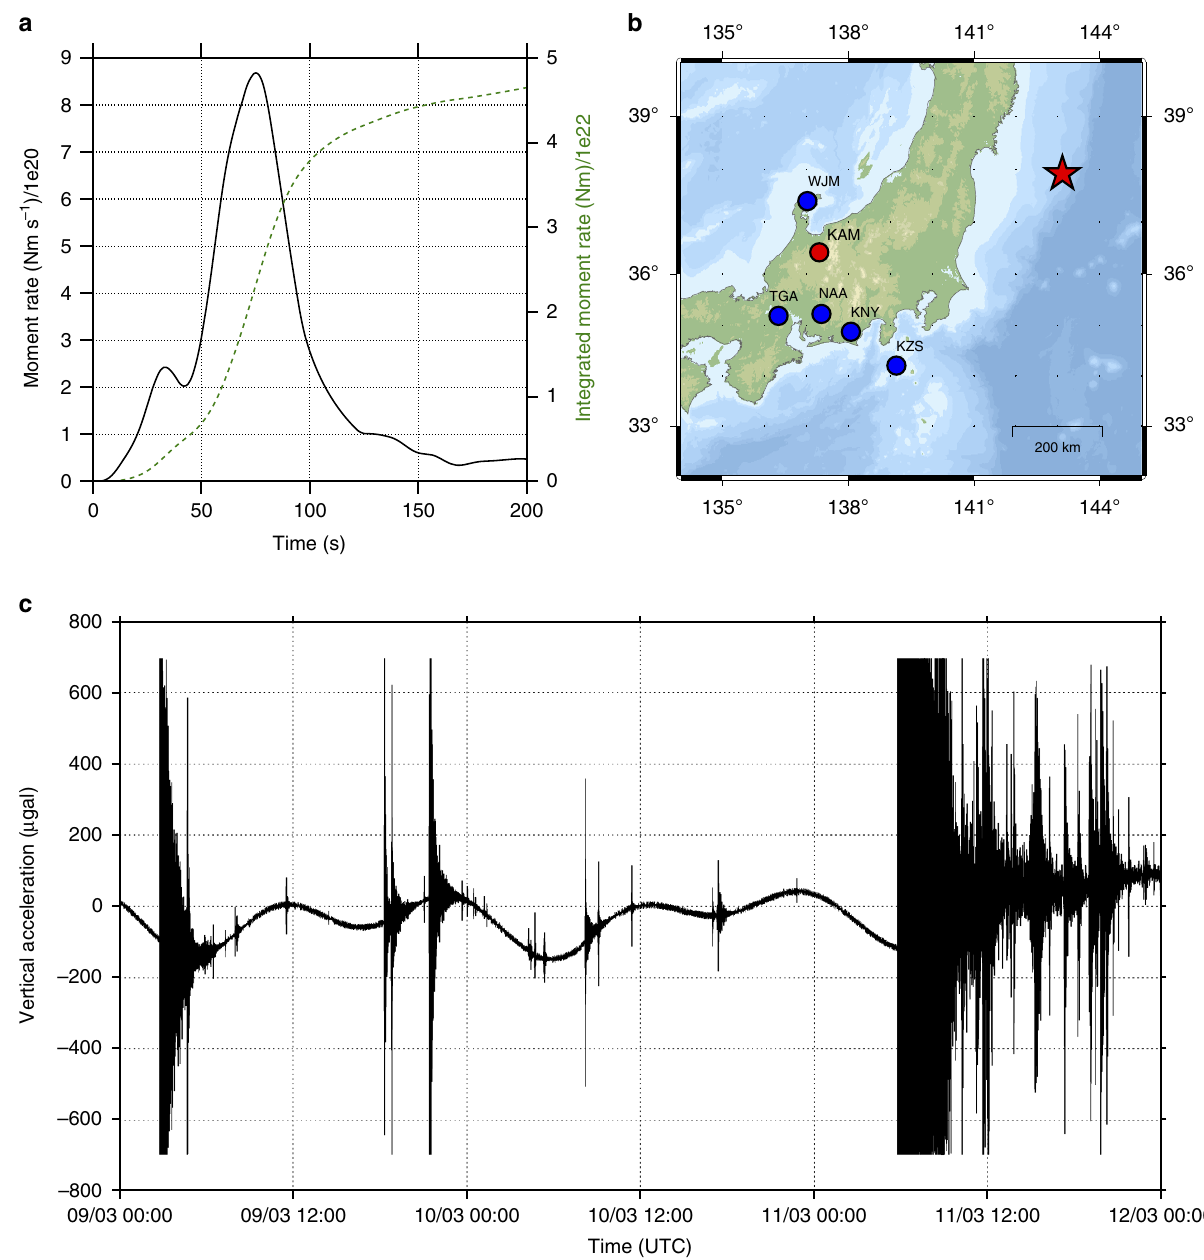
Figure 1 | The 2011 Tohoku-Oki earthquake and gravity changes recorded by the Kamioka superconducting gravimeter. ( a ) Seismic moment (dashed line) and moment rate (solid line) time-functions of the Tohoku-Oki earthquake 12 . ( b ) Locations of the epicentre (red star), the Kamioka Observatory (red circle) and its five nearest F-net seismic stations (blue circles). ( c ) Three days of gravimetric recording at Kamioka Observatory, starting on 9 March